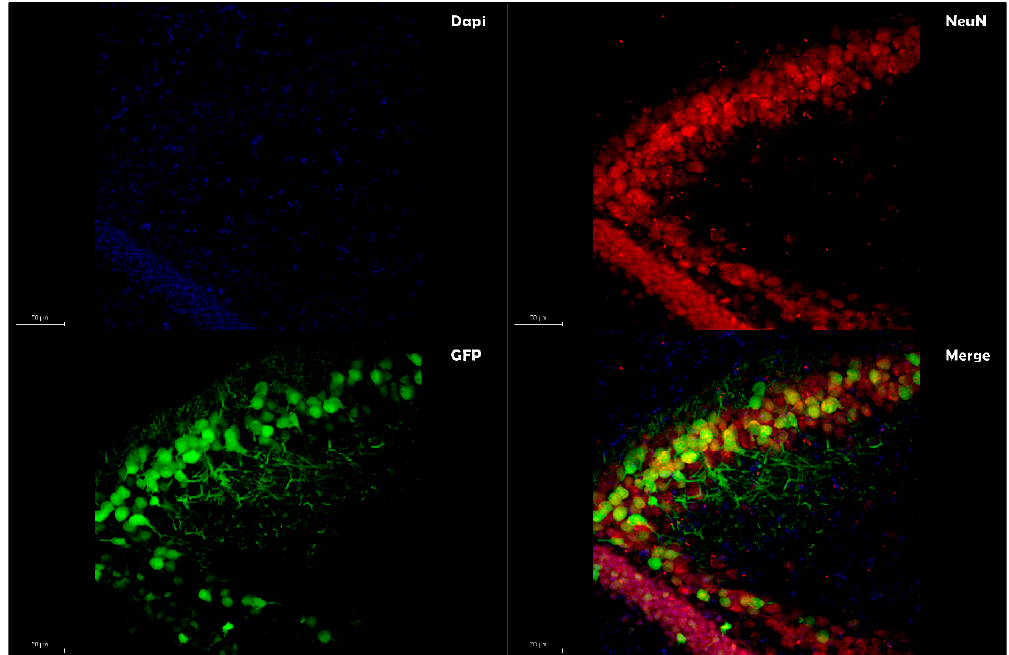
Figure 1. Exosome-enveloped adeno-associated viruses (AAVs) enhance transgene expressions in neurons. The co-localization of GFP (green) with the neuronal marker NeuN (merge) expressed by exosome-enveloped AAV vectors. Images were taken using a Leica SP8 confocal microscope at 20× magnification. Scale bar represents 50 µm.